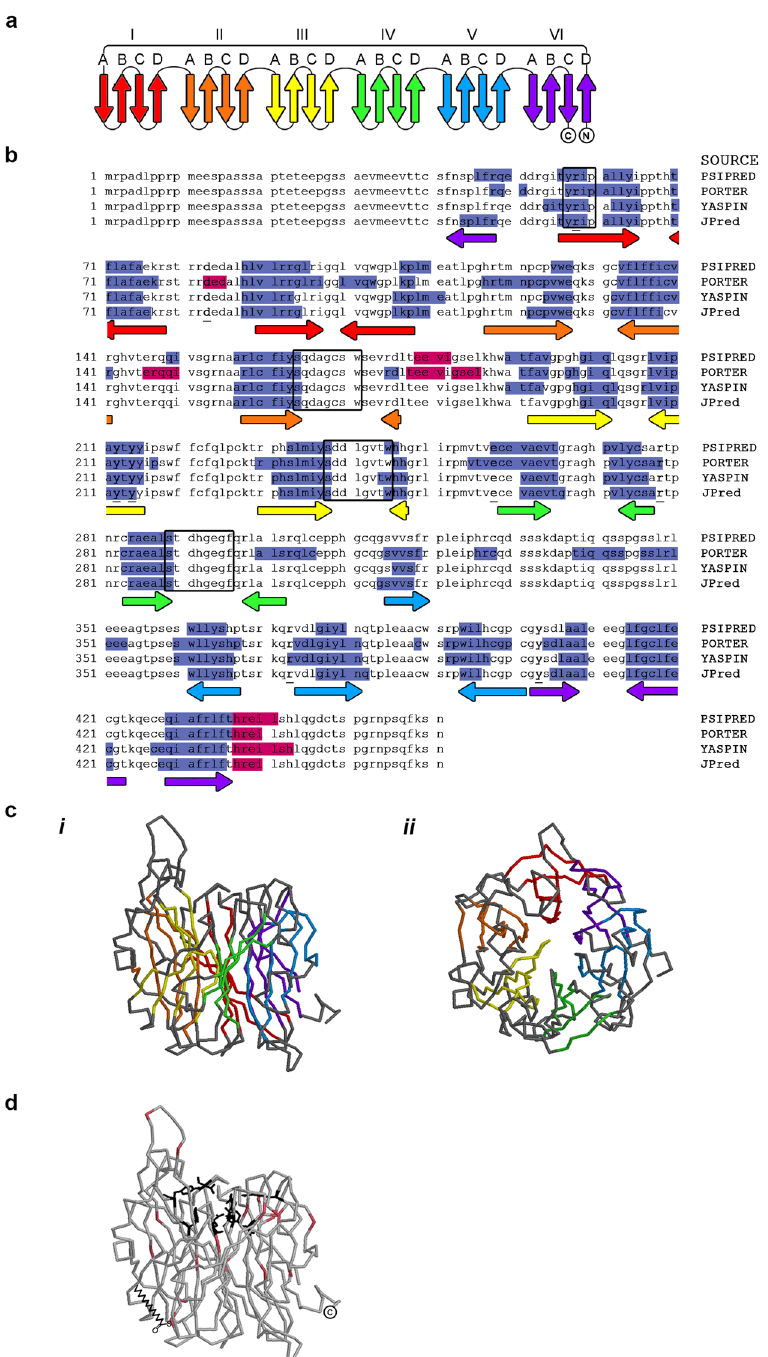
Figure 4. Secondary structure prediction and homology modeling of Neu3. ( a ) Common folding topology for the β -propeller domain of viral, bacterial and Neu2 sialidases. The fold consists of six (I-VI) four-stranded (A–D) antiparallel β -sheets (arrows) arranged as the blades of a propeller, with the N- and C-termini close to each other. ( b ) Prediction of secondary structure elements in human Neu3 sequence using different servers available on-line. Predicted β -sheets and α -helix are shown in blue and magenta boxes, respectively. Some of the highly conserved active site residues are shown in bold and underlined, whereas the conserved F/YRIP motif near the N-terminus and the three Asp boxes are shown in black boxes. The orientation of the predicted antiparallel β -sheets is shown with arrows. ( c ) Homology model of Neu3 using Neu2 crystal structure as a template. The β -sheets of the β -propeller backbone are shown in the same colors as in Fig. 4a and b. ( i ) Side view. ( ii ) Top view. ( d ) Schematic model of Neu3, highlighting in black sticks some residues from the active site. The C-terminus is indicated. Cysteins are labelled in pink and a hypothetical fatty acid is drawn attached to one of